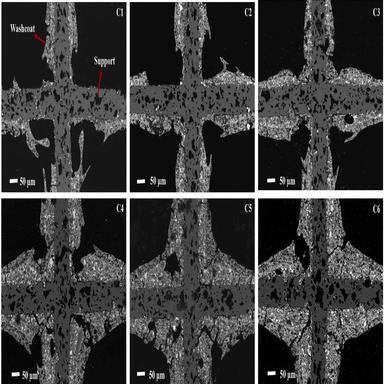
BSE images displaying the view of the inlet (C1) to outlet (C6) region of the aged catalyst.